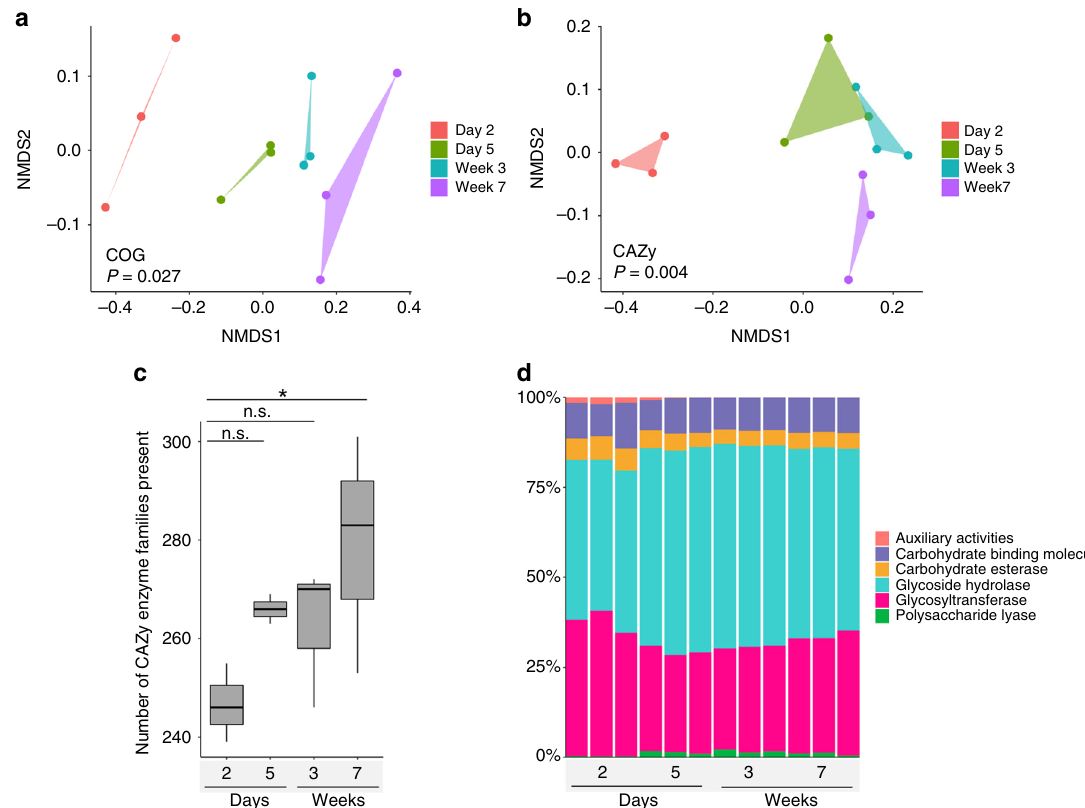
Fig. 9 Functional capacity of the calf fecal community over time. a 2-dimensional NMDS based on Bray-Curtis dissimilarity of COG pathways (stress of 0.07). b 2-dimensional NMDS based on Bray-Curtis dissimilarity of CAZy results (stress of 0.1). c Boxplots (boxes representing IQRs with median shown in black) of the richness of observed CAZy enzymes (families) in dairy calves from day 2 to week 7. d Bar plots of the relative abundance of CAZy families per class of enzymes over time. * P < 0.05, and n.s. indicates P > 0.05 by Friedman ’ s test followed by multiple pairwise comparisons using Nemenyi post- hoc test. Polygons were applied to group samples of NMDS plot at the same time